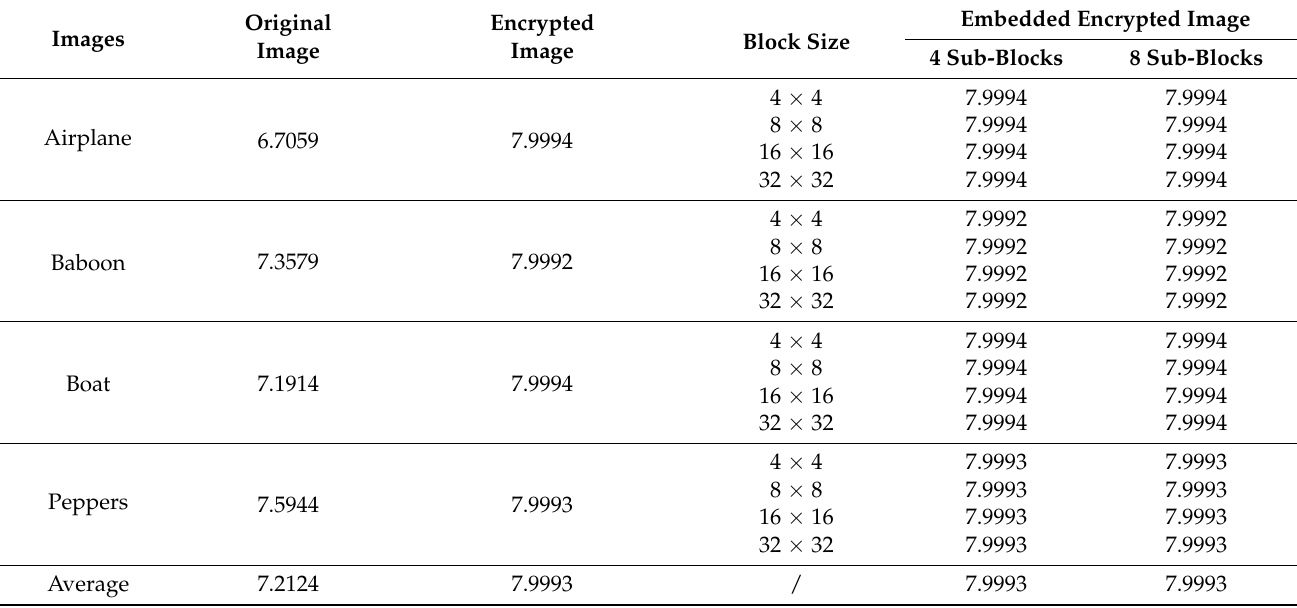
Table 5. Information Entropy of Different Images in Two Scenarios.